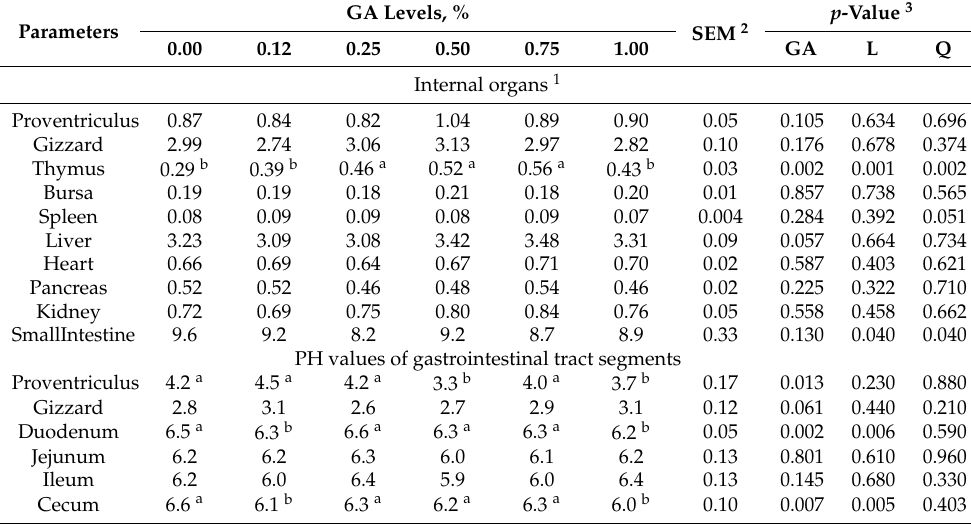
Table 5. Effect of gum Arabic (GA) powder on the relative weight of internal organs and pH values of gastrointestinal tract segments in male broiler chickens on d 10 of age.